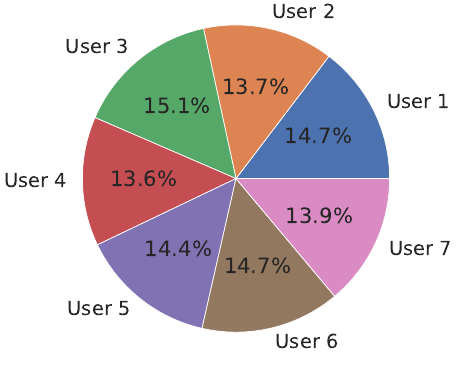
Figure 10. Distribution of vectors per user in the general